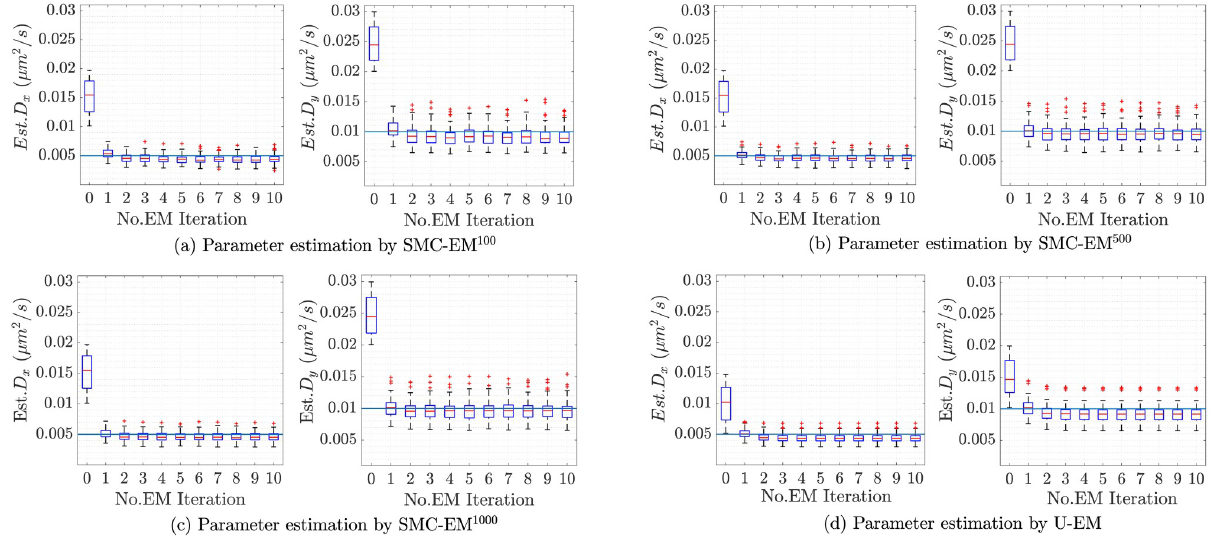
Fig 5. Box plots of estimated D x and D y by SMC-EM and U-EM. The true values of the diffusion coefficients are shown as solid horizontal lines in each plot. Note that the red line inside the box is the median, the edges of the box represent the first and third quartiles, the vertical dashed line indicates the bounds for data within 1.5 times the interquartile range, and the red + symbols are data points outside this range.